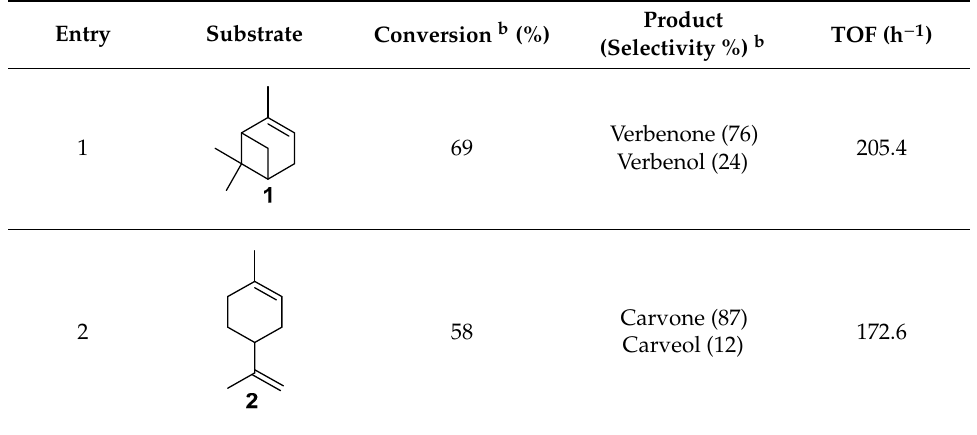
Table 23. Polymer-anchored nickel(II) complex in allylic oxidation of model terpenes a (adapted from reference [78]).